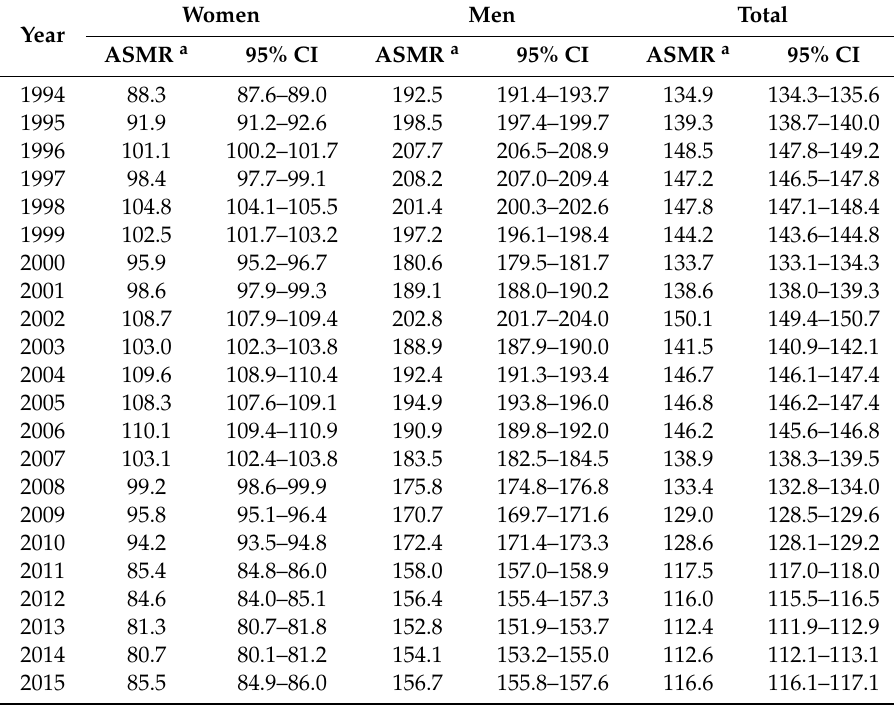
Table A4. Acute myocardial infarction age-standardized mortality rates in Romania (1994–2017).